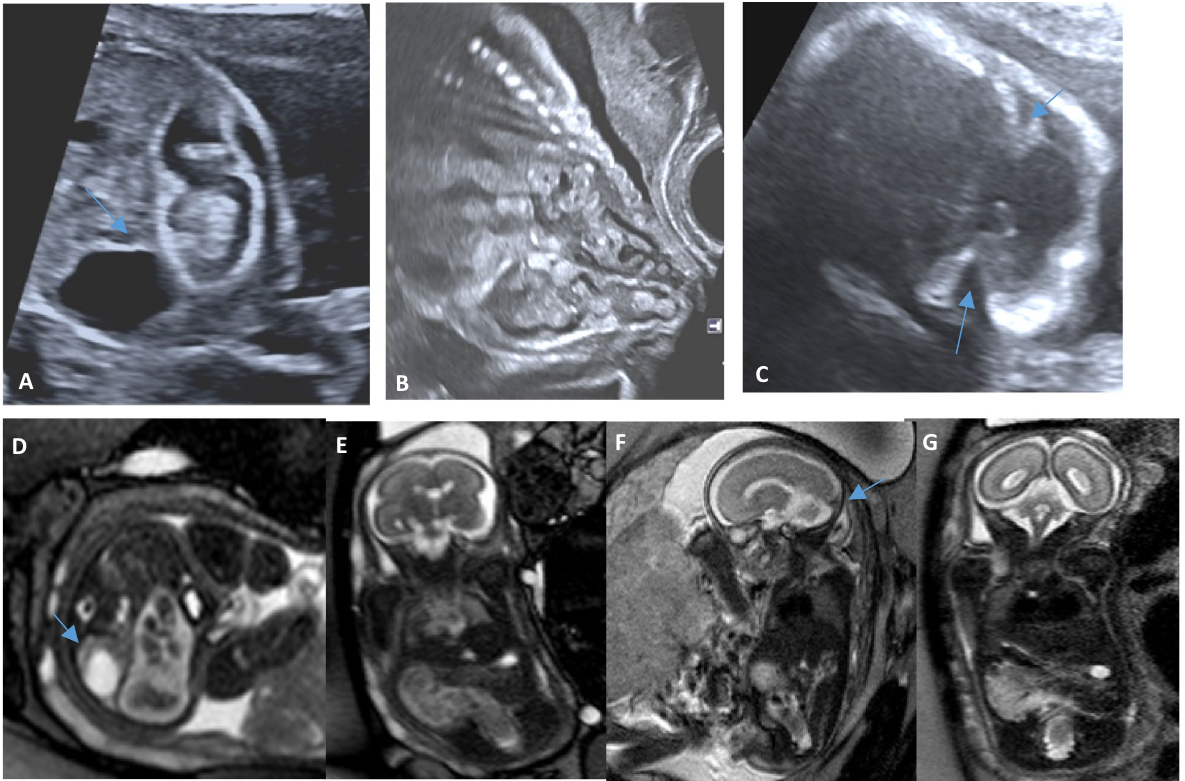
Fig. 2 A 34-year-old female 28 weeks pregnant underwent a routine 4D US revealing multiple fetal anomalies. Ultrasound findings: A Axial trans-abdominal image of the fetal pelvis, B sagittal transvaginal image of fetal abdomen and pelvis shows the dilated sigmoid colon and rectum down to the level of the anorectal junction with absent echogenic anal dimple and multiple echogenic intra-luminal well-defined lesions (enterolith). A The image also shows a well-defined cystic structure posterior to the dilated rectum with a thin echogenic wall. C Axial trans-abdominal image of fetal neck revealing subcutaneous cystic lesion in the fetal nape with communication with a bony defect in the occipital bone. Fetal MRI findings: D, E, F, G axial, coronal, sagittal, and coronal T2WIs, respectively, revealed dilated rectum, sigmoid, and descending colon with multiple enteroliths (arrowed) within (low T2 signals oval structures) and detected narrowed rectal segment below the apex of the bladder (low type). D The axial image revealed a low T2 signals of a cystic lesion (arrowed) posterior to the rectum (denoting calcification). G Coronal T2WIs revealed smooth fetal perineum with an absent anal dimple. F The sagittal image revealed the occipital cystic lesion. Combined US and MRI Diagnosis: Low-type anorectal malformation with recto-vesical fistula, meconium pseudocyst, and occipital encephalocele likely representing sequel of VACTERL anomaly. IUFD at GA 29